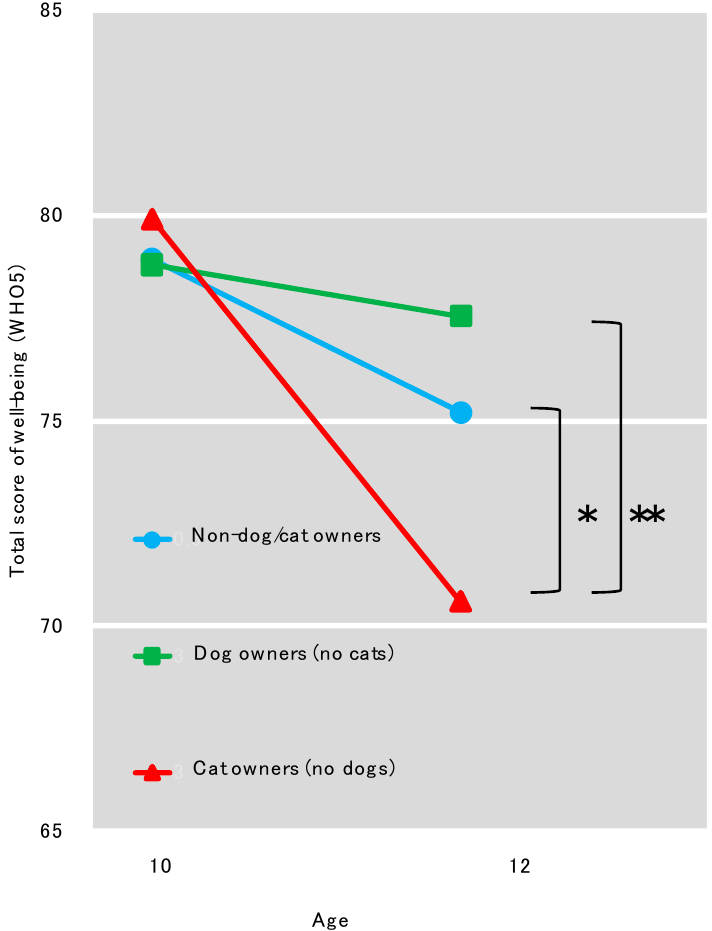
Figure 1. Averages of well-being (WHO5) at ages 10 and 12 among non-dog / cat owners, dog owners, and cat owners (* p < 0.05, ** p < 0.01). Two-way mixed-design analysis of variance (ANOVA) showed significant interaction of time points and owner types ( F (2, 2572) = 6.78, p = 0.001). Simple main e ff ect of owner types was not significant at age 10 ( F (2, 2572) = 0.18, p = 0.835), but it was significant at age 12 ( F (2, 2572) = 6.61, p = 0.001). Bonferroni adjustments were administered for multiple comparisons and found significant pairs at age 12 as follows: cat owners (owned no dogs) and non-dog / cat owners ( p = 0.017) and cat owners (owned no dogs) and dog owners (owned no cats) ( p = 0.001). Other pairs were not significant. The simple main e ff ect of time points was significant in non-dog / cat owners ( F = 85.55, p < 0.001) and cat owners (owned no dogs) ( F = 26.21, p < 0.001) but not significant in dog owners (owned no cats) ( F = 1.38, p =